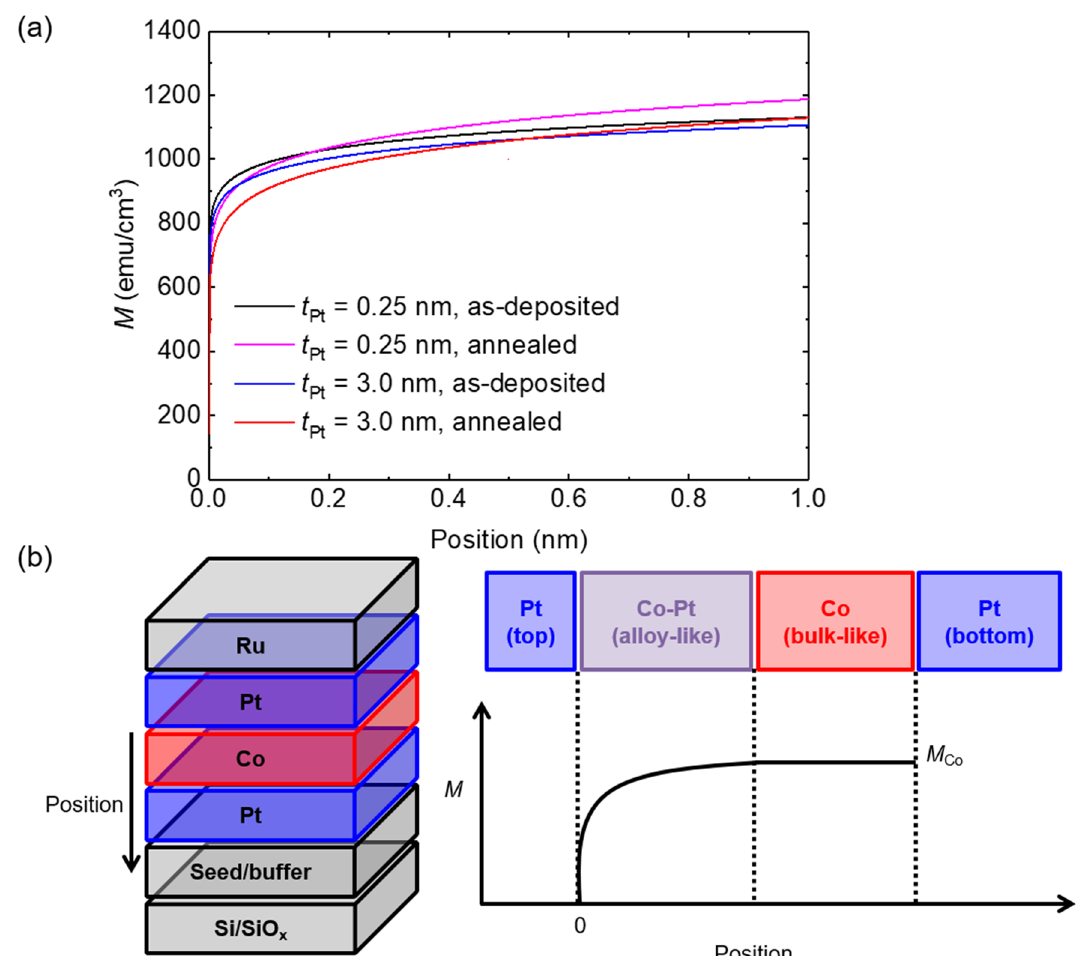
Figure 3. ( a ) Results for the M values as a function of the position in Co region at Pt thicknesses of 0.2 and 3.0 nm in the as-deposited and annealed samples. ( b ) Schematic illustration of the [Pt/Co/Pt] trilayers system (left) and the M values as a function of the position in the Co region